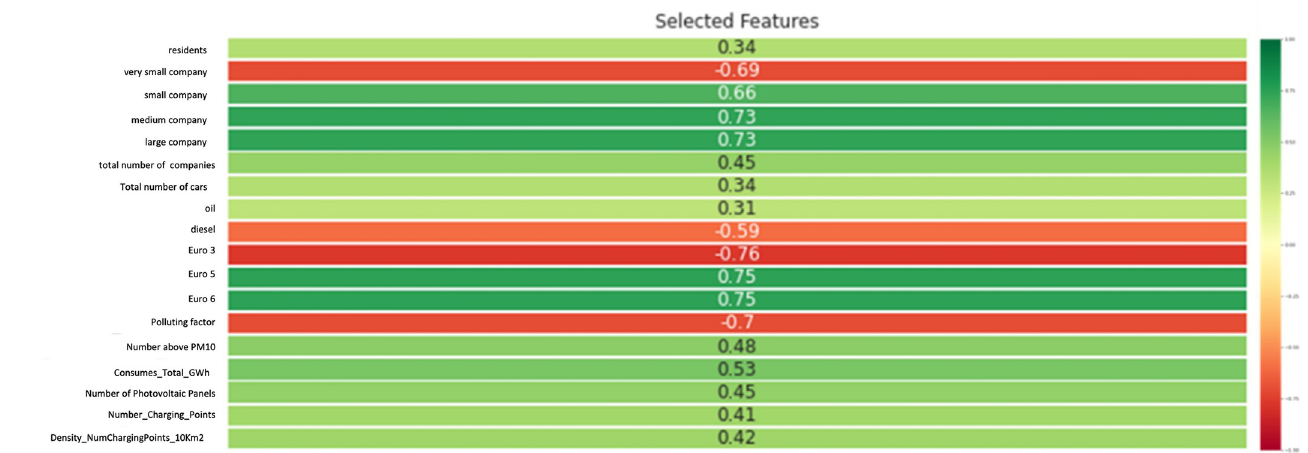
Fig 7. Regional selected features with correlation equal or higher than 0.3 in absolute value. Values are included in the range [–1,1].